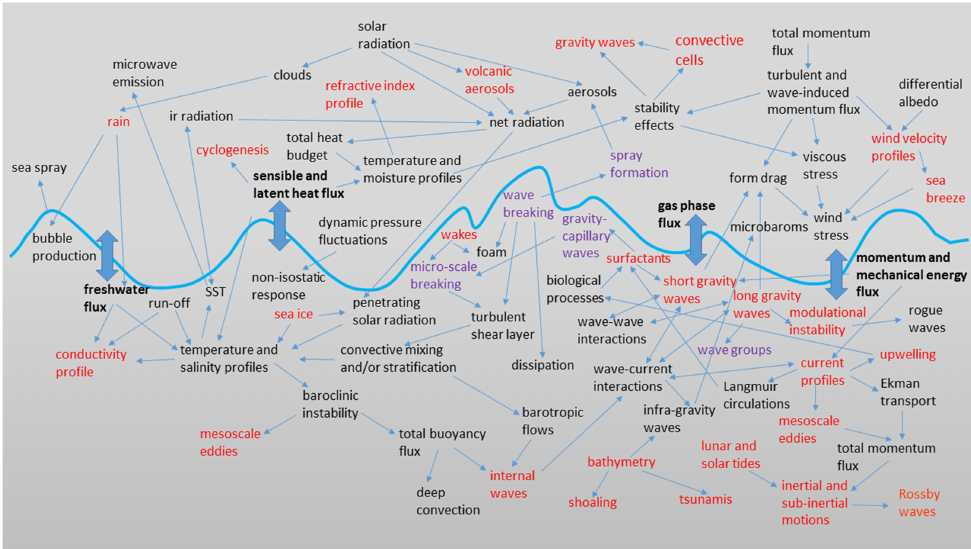
Figure 16. Some of the principal oceanic and atmospheric phenomena that have been considered by the HF radar remote sensing community. Specific signature models have been developed by those shown in red.